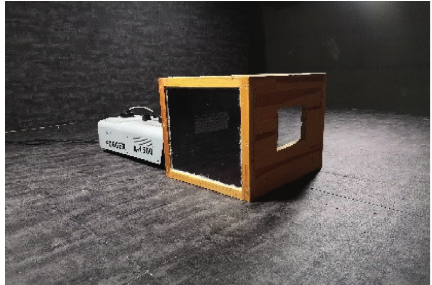
Figure 12: The experimental